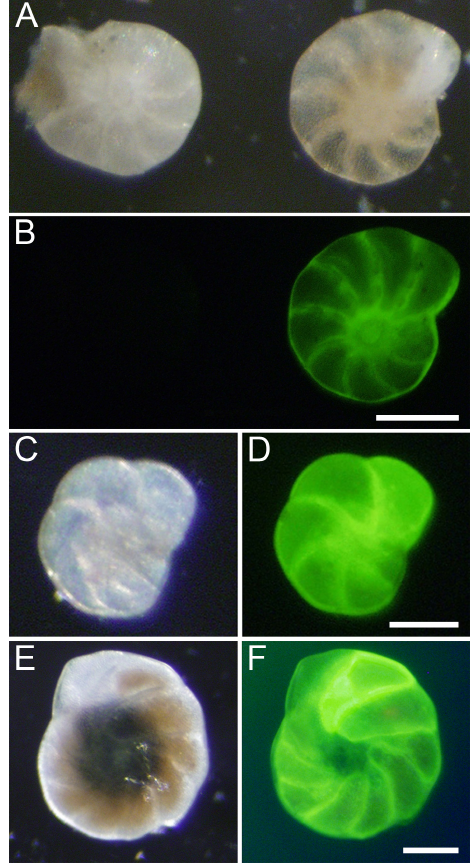
Figure 3. Paired micrographs of foraminifera after calcein osmotic pump incubations. Reflected (a) and epifluorescence (b) images of two Cribroelphidium sp. Note the specimen on the right fluo- resces strongly in (b) (vs. left specimen showing no fluorescence). Thus, the specimen on the right grew during calcein incubation and the other did not grow or was too far removed from the osmotic pump. Reflected (c) and epifluorescence (d) images of fully fluores- cent small calcareous foraminifera, too small to speciate. Reflected (e) and epifluorescence (f) images of fully fluorescent Cassidulina sp. Note that the penultimate chamber fluoresces brightest, indicat- ing its calcification during calcein incubation. The youngest cham- ber was likely being precipitated at the time of sampling. Scales: b , f = 100µm; d =